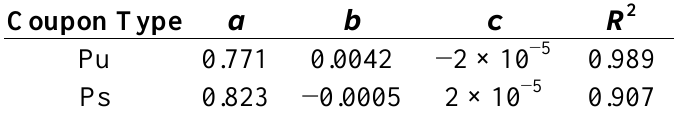
to P correlation (Figure 8). N c